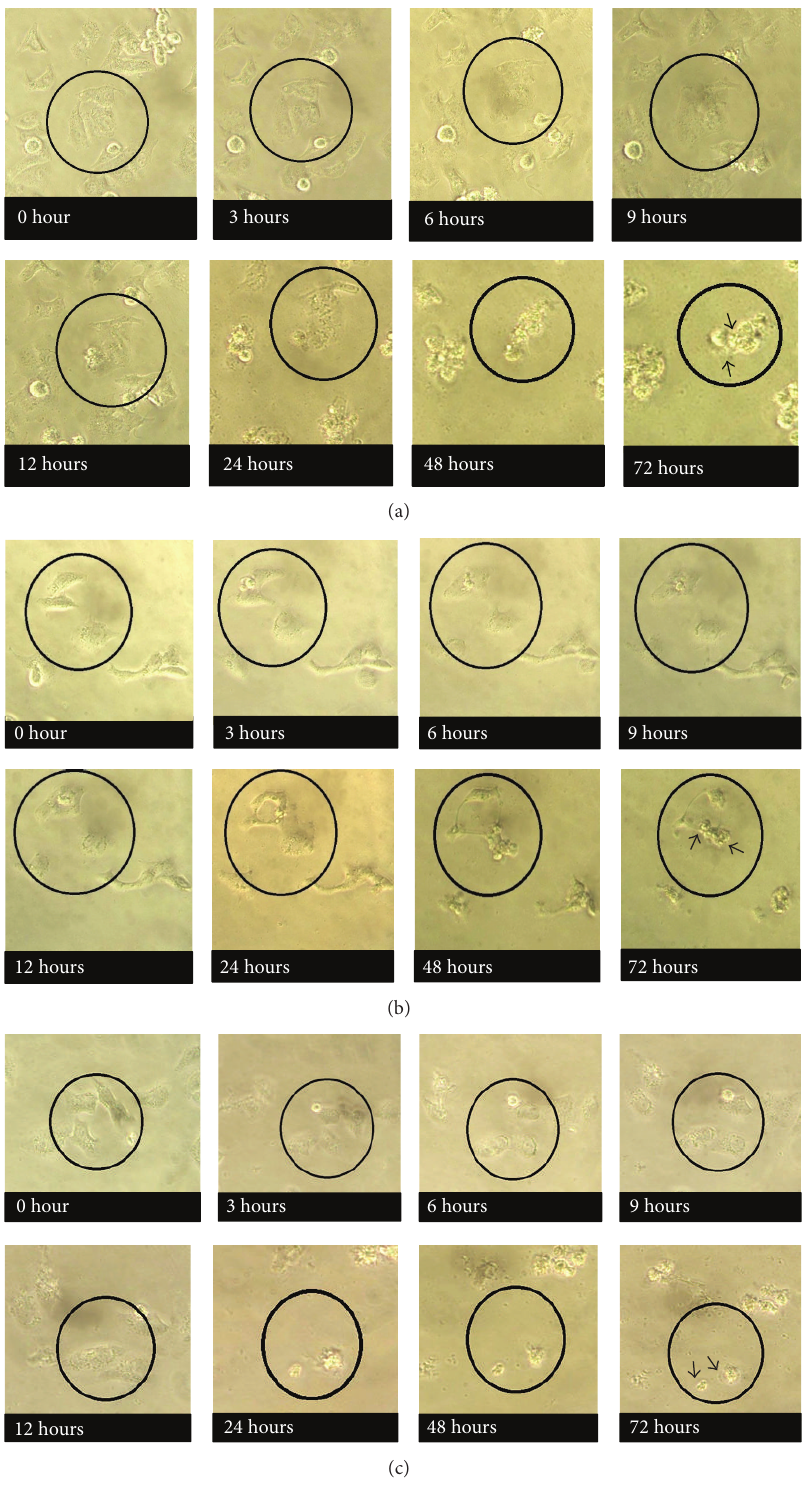
Figure 1: Responses of KB cells to 100 𝜇 g/mL extract of (a) Brucea sp., (b) Azadirachta sp., and (c) Typhonium sp. monitored from 0hr to 72 hr following treatment. Sign of cell attrition was focused on cells within the black circles. The arrow heads pointed at the apoptotic cells. Images were obtained using an inverted microscope.